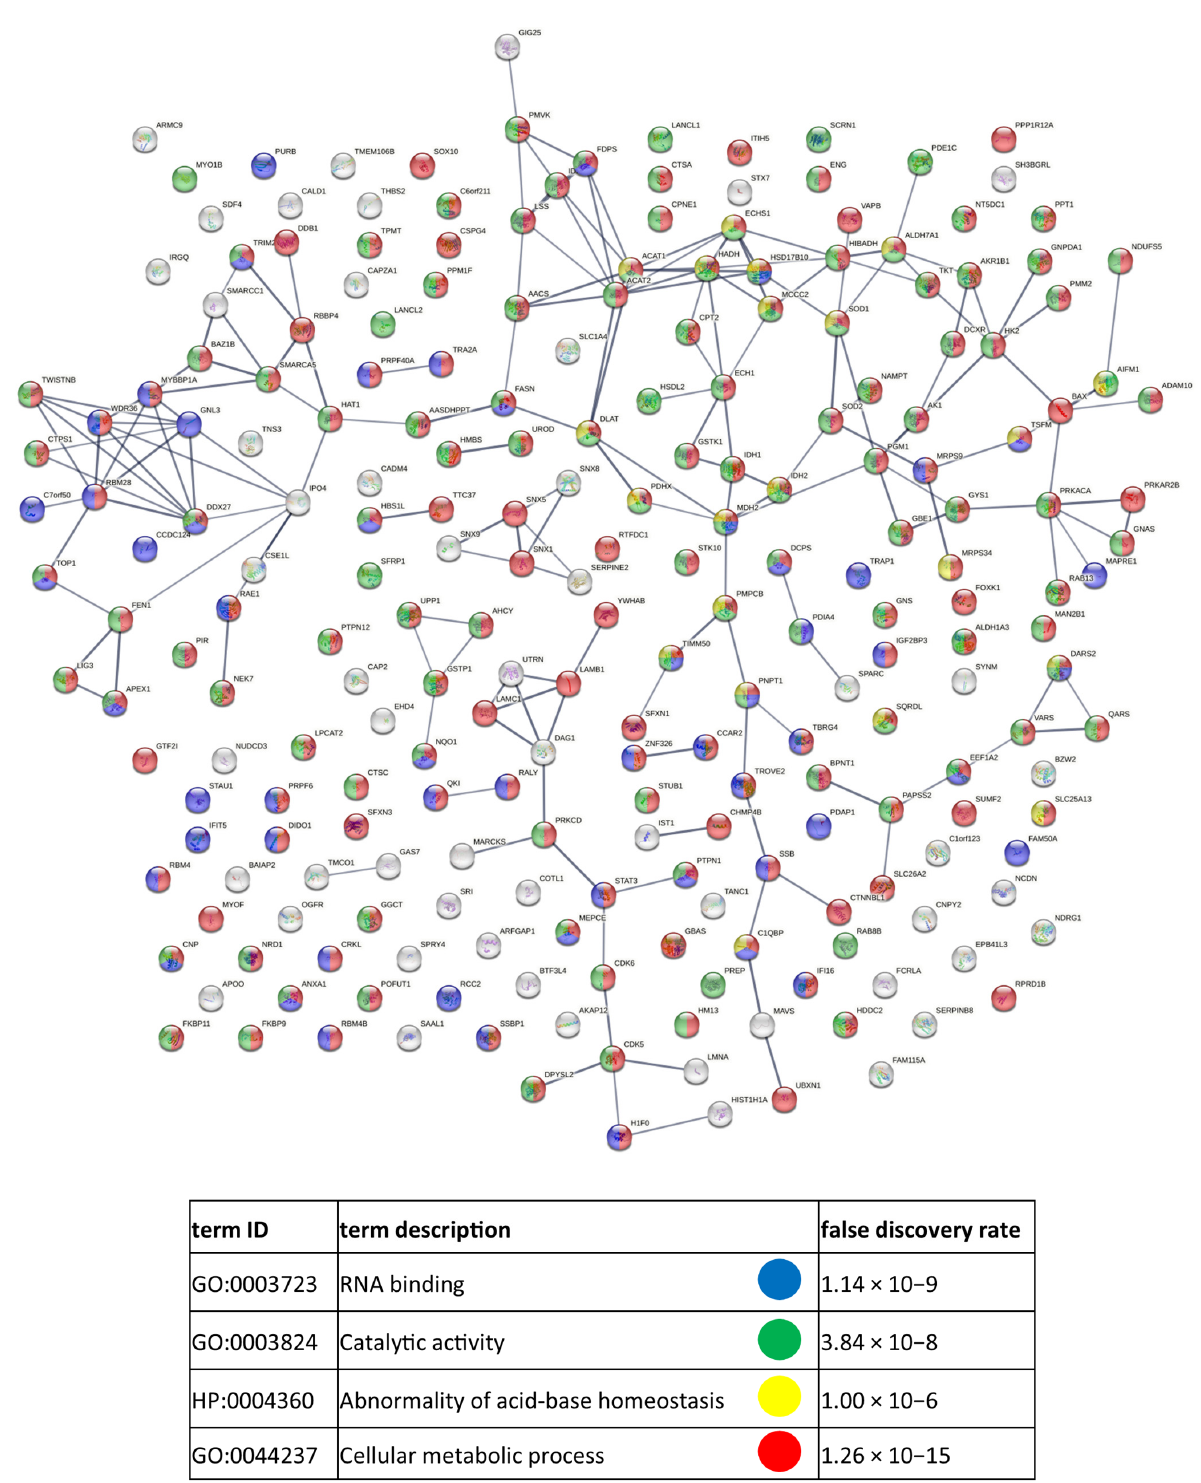
Figure A7. Diagram of functional protein association networks prepared with the use of STRING v. 11.0 software for proteins identified in WM266-4-derived exosomes but not found in any repli- cates of WM115-derived exosomes. The selected, strongly represented pathways are presented as an interactome. A complete analysis is presented in Supplementary Data S3.